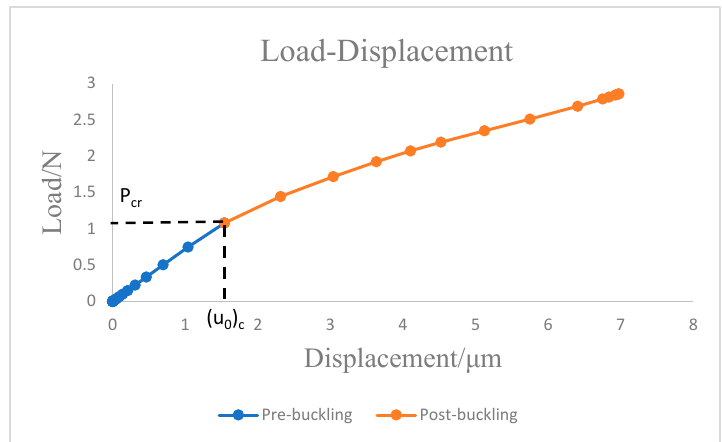
Figure 4. Nonlinear buckling response simulation of Cu plates.